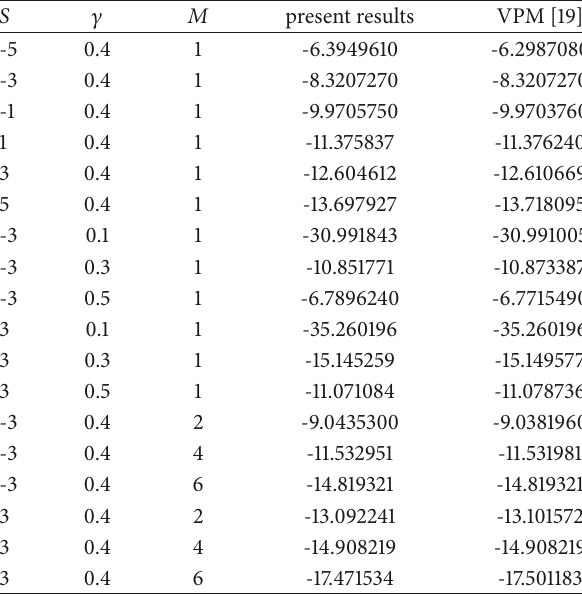
same case happened when 𝜂 ≤ 0.4 , and the reverse situation of their curves happened for 0.4 < 𝜂 ≤ 1 . Figure 6 indicates an effect of magnetic number 𝑀 for axial and radial velocity. This effect is similar to the effect of 𝑀 in the positive value of squeeze